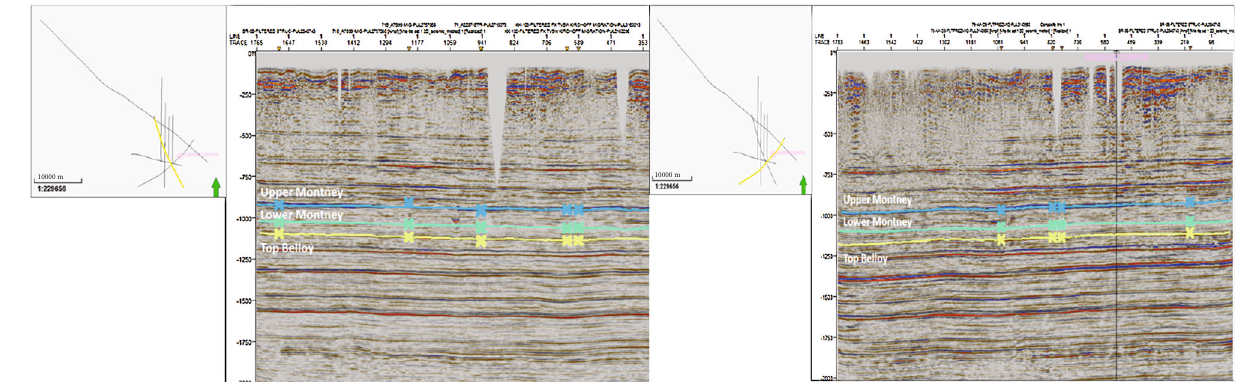
Figure 4: Well to seismic calibration with Alberta dataset: (a) seismic pro fi le KK-103 with well 100090407226; (b) seismic pro fi le KK-101 which were perpendicular with KK-103. This seismic interpretation surface (upper, lower Montney, and Belloy Formation) was divided based on the well log (GR) interpretation.